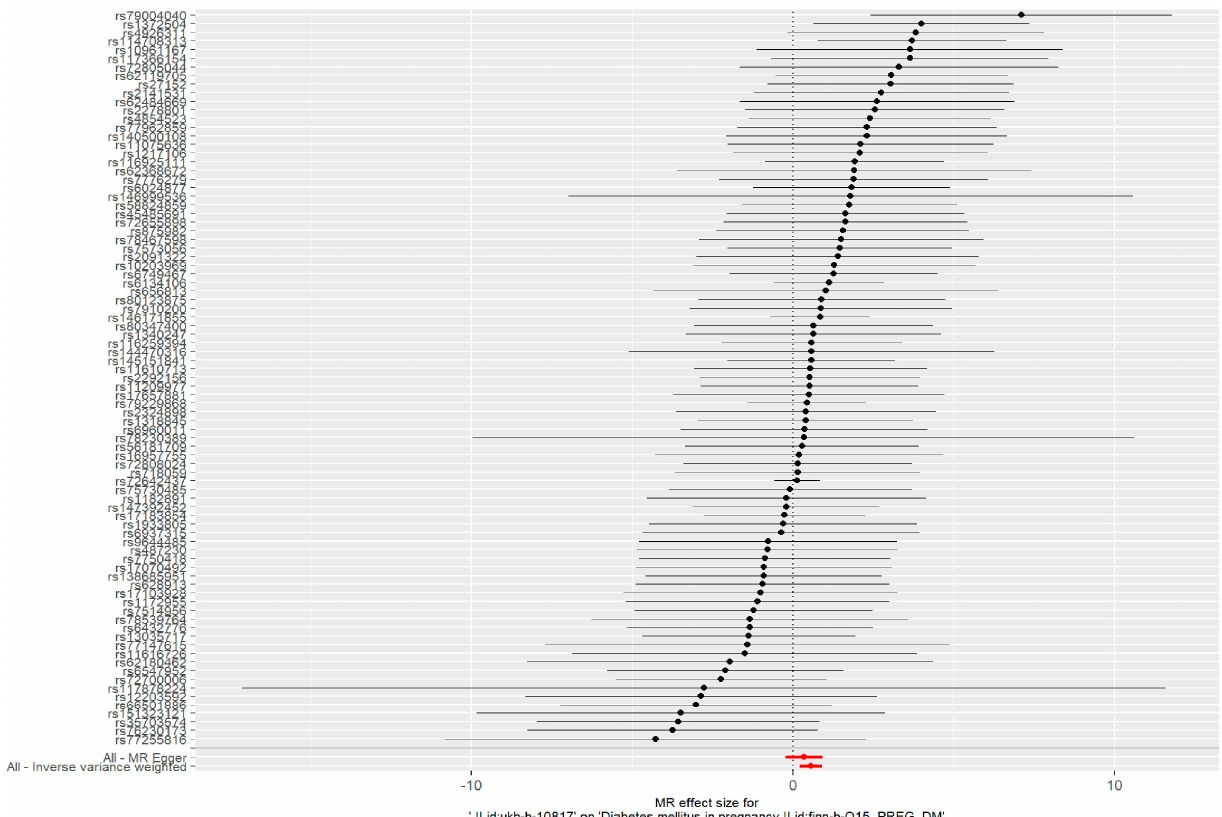
Figure 1. Forest plots of the causal effects between PM2.5-associated SNPs and risk of GDM.